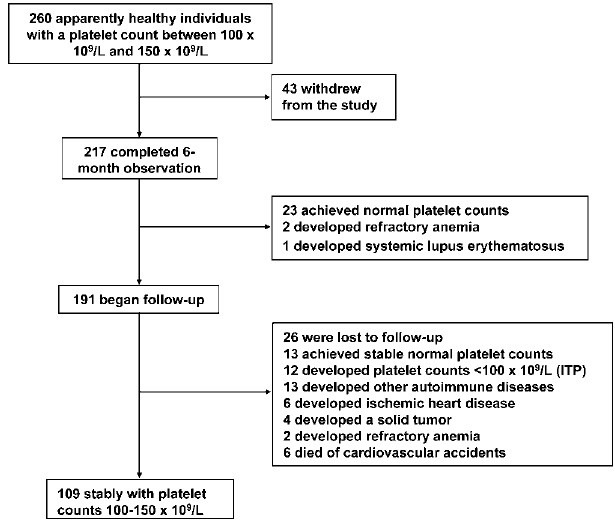
Figure 1. Study Design and Results